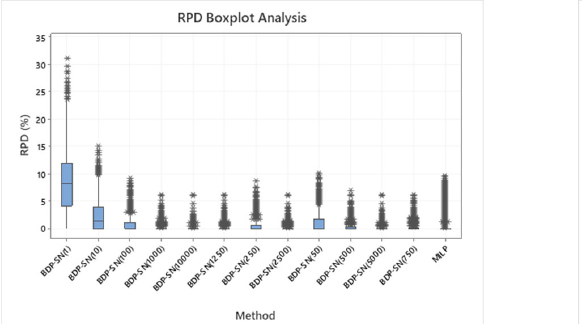
Fig. 10. Boxplot relative to the RPD data for the second experimental set